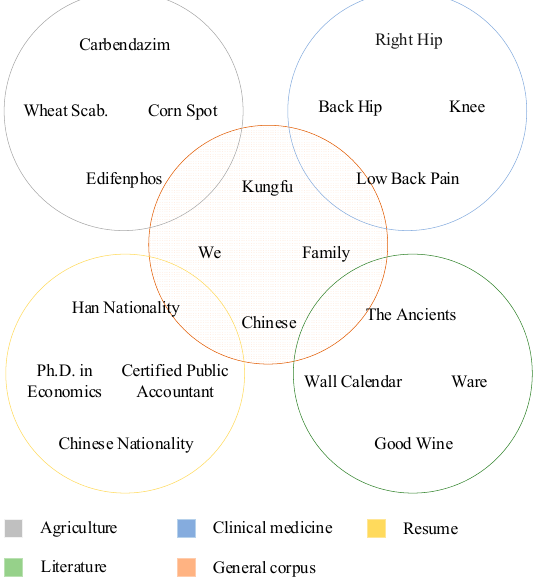
Figure 1. Visualizations of data spaces of the datasets in different fields.